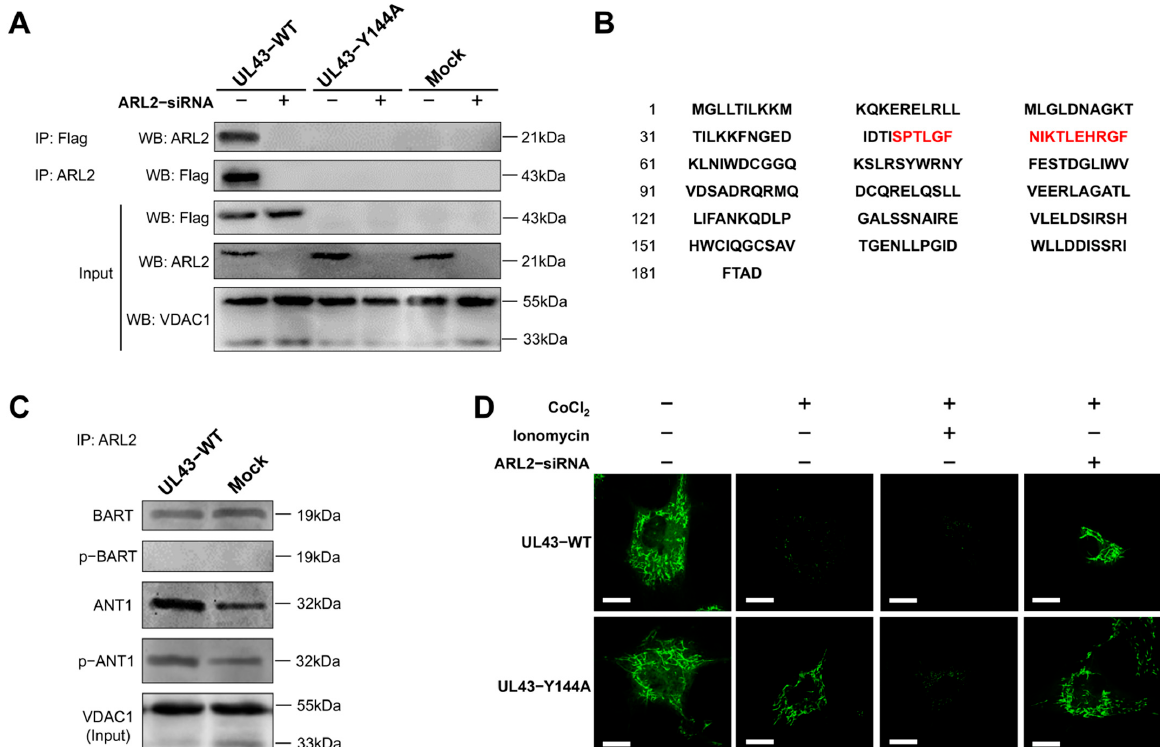
Figure 6. UL43 protein binding to ARL2 and phosphorylation of ANT1. ( A ) Co–immunoprecipitation assay in mitochondrial proteins of UL43–WT, UL43–Y144A, Mock, performed with co-transfect of ARL2-siRNA. ( B ) The peptide sequence is detected by mass spectrometry, and the ARL2-specific binding sequence is marked in red. ( C ) Co-immunoprecipitation assay in mitochondrial proteins of UL43-WT and Mock, detecting the phosphorylation level of BART and ANT1. ( D ) Fluorescent image of mitochondrial membrane pores opening test, UL43-WT and UL43-Y144A were treated with CoCl 2 , ionomycin and ARL2-siRNA. Scale bar = 5 µ m. The data shown in each panel are representative of three independent